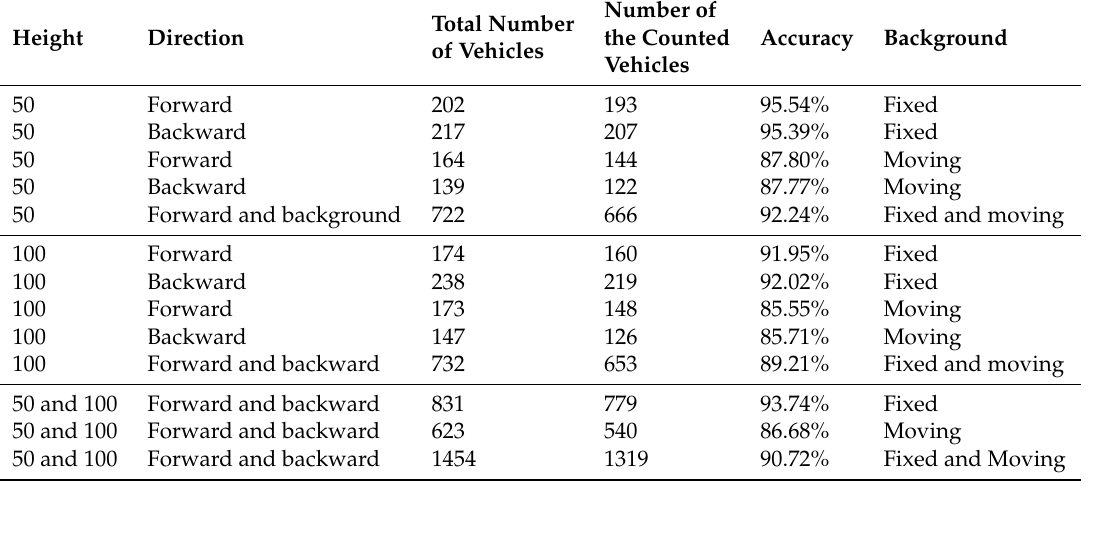
Table 3. Accuracy analysis on test video.